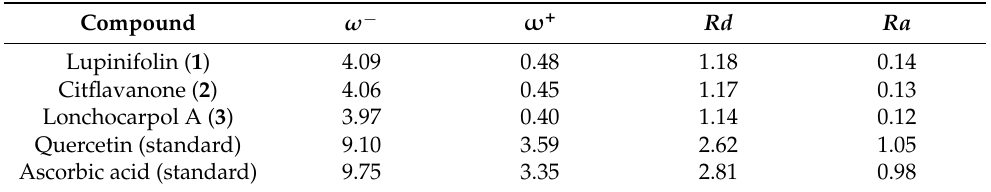
Table 2. Electro-donating power ( ω − ), electro-accepting power ( ω + ), and indexes ( Rd and Ra ) of 1–3 and standard compounds at the B3LYP/6-31+G(2d,2p) level of theory (in eV). Compound ω − ω + Rd Ra Lupinifolin ( 1 ) 4.09 0.48 1.18 0.14 Citflavanone ( 2 ) 4.06 0.45 1.17 0.13 Lonchocarpol A ( 3 ) 3.97 0.40 1.14 0.12 Quercetin (standard) 9.10 3.59 2.62 1.05 Ascorbic acid (standard) 9.75 3.35 2.81